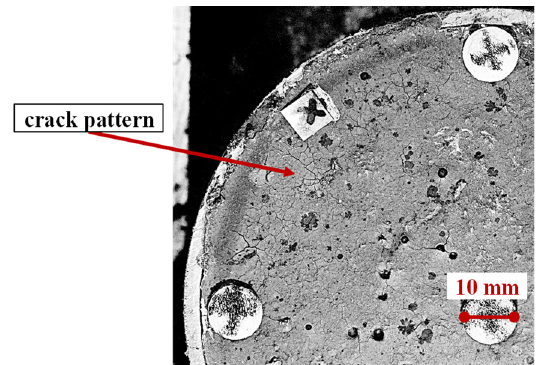
Figure 11. Detail of the surface of the W ‐ GPM 40 mm disc with very fine drying